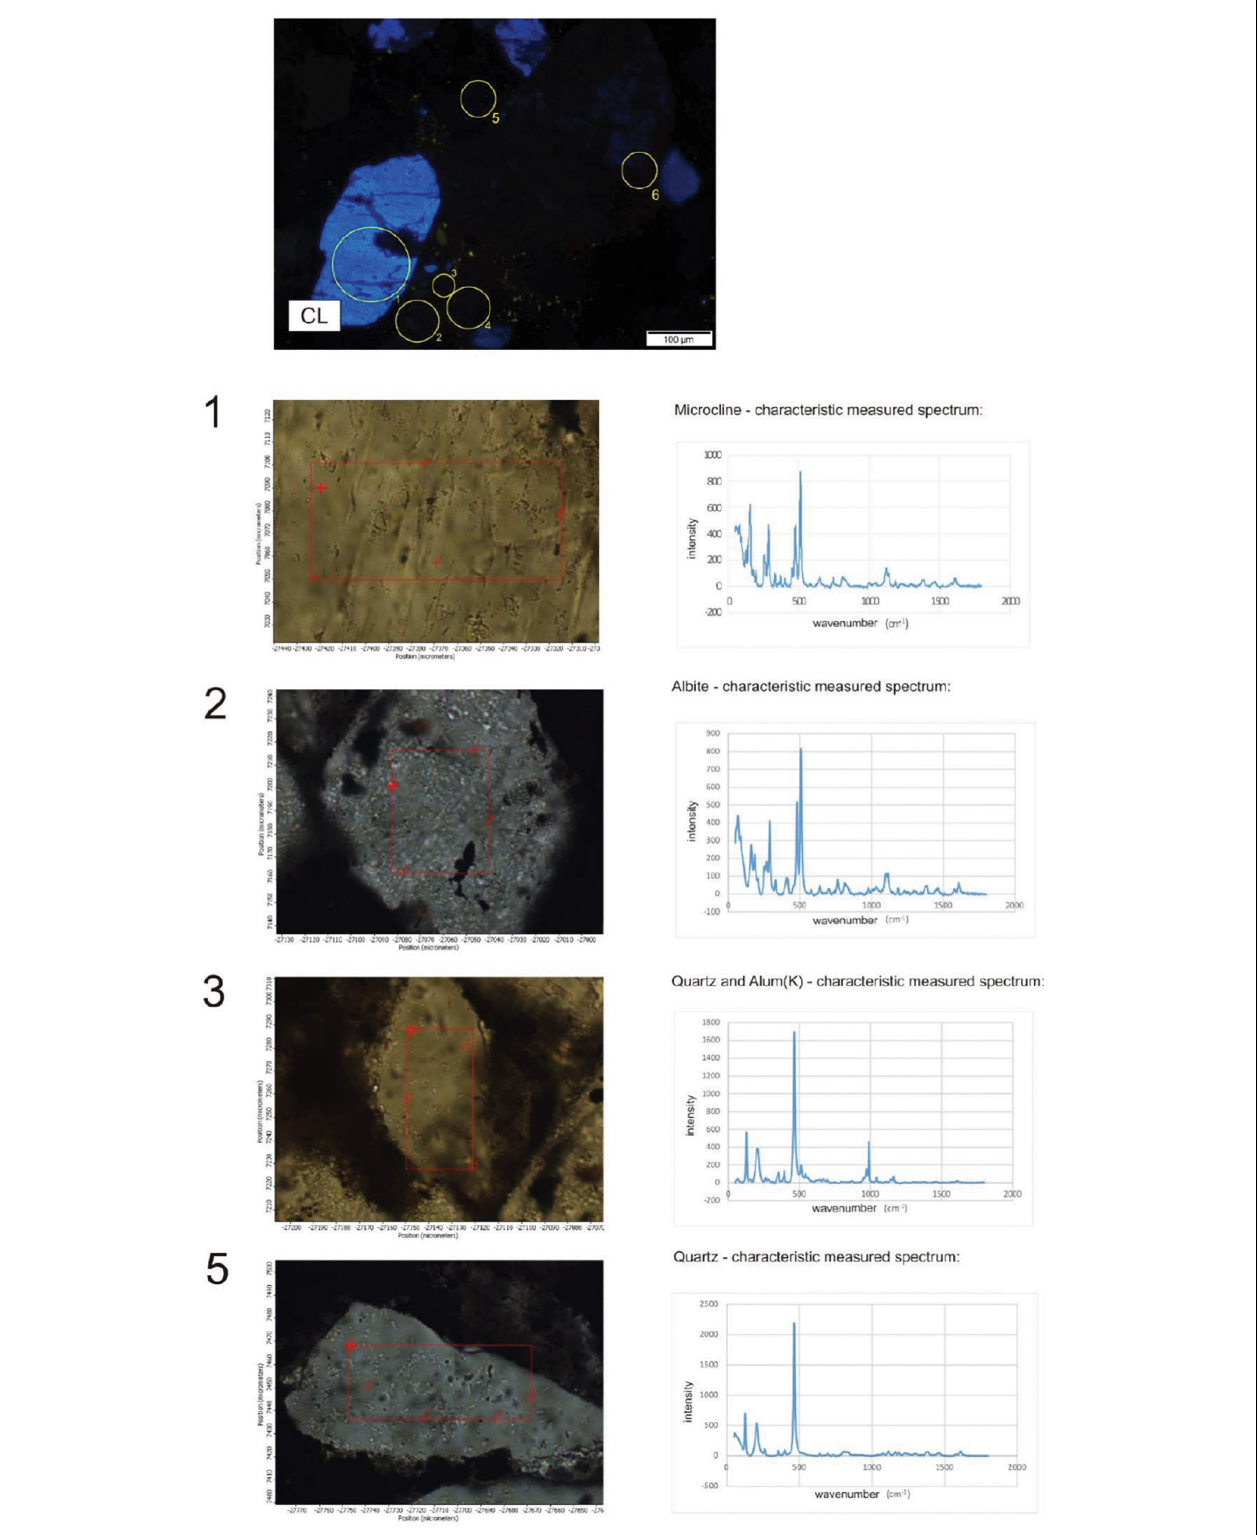
FIGURE 9 | Distribution of minerals in sample COR-10. Point measurement by Raman spectroscopy. Circles and numbers on CL image show spots of analyses. Composition of grains 4 and 6 is the same as 2 (albite).